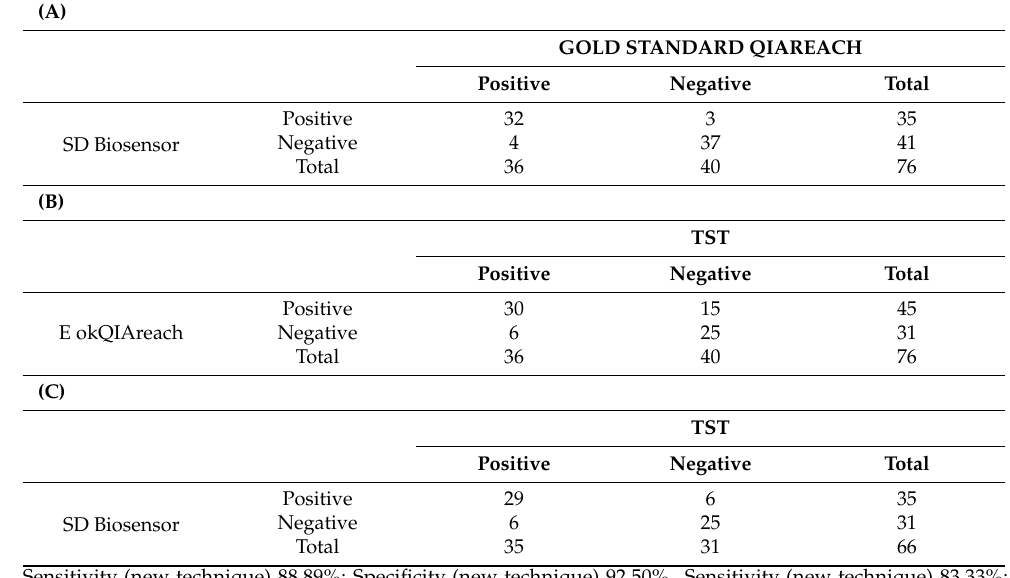
Table 2. (A). Comparison between the new IGRA technique and the gold standard. Samples collected from HBLT patients. (September to December 2022). (B). Comparison between the new IGRA technique and the gold standard. Samples were collected from HBLT patients (September to December 2022). ( n = 76). (C). Comparison between the new IGRA technique and the gold standard. Samples collected from HBLT patients (September to December 2022). ( n = 76).